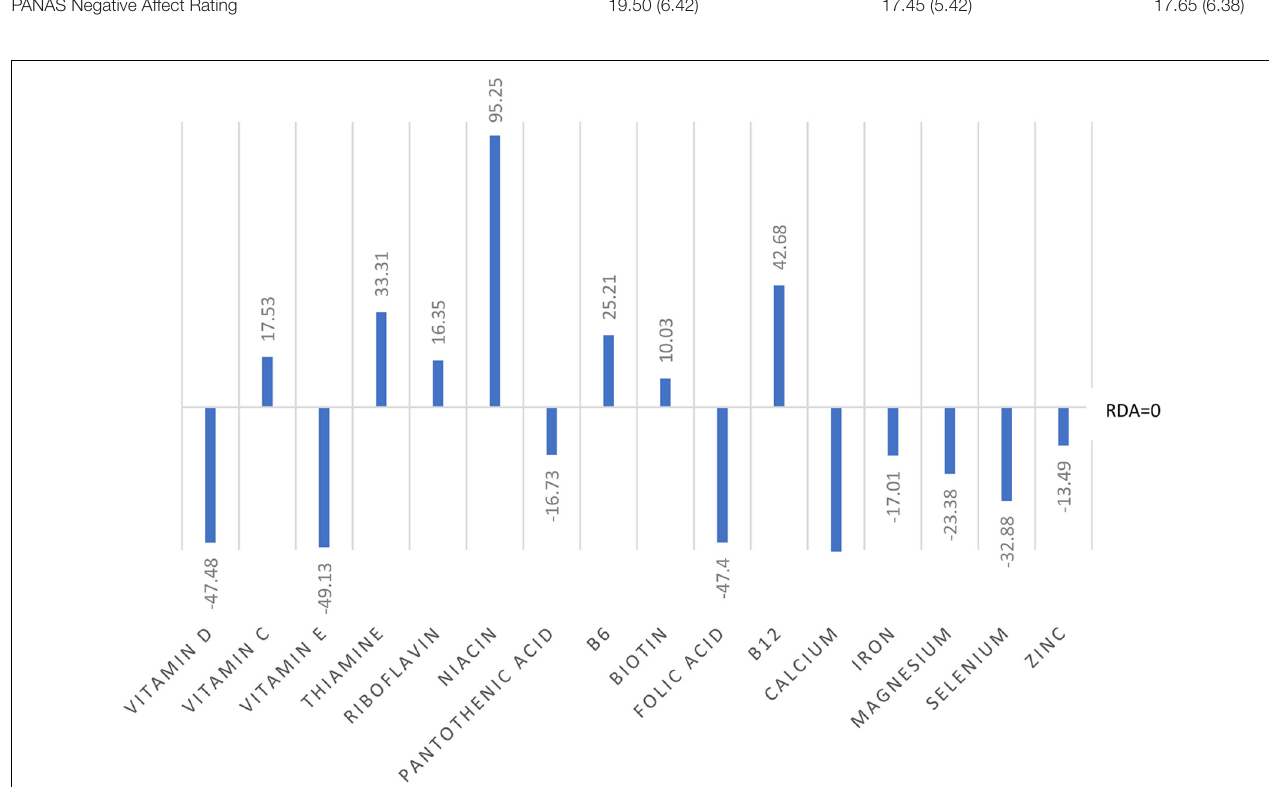
FIGURE 1 | Dietary intake of micronutrients as a percentage below and above reference dietary intake (RDI) for the whole cohort ( N = 60).